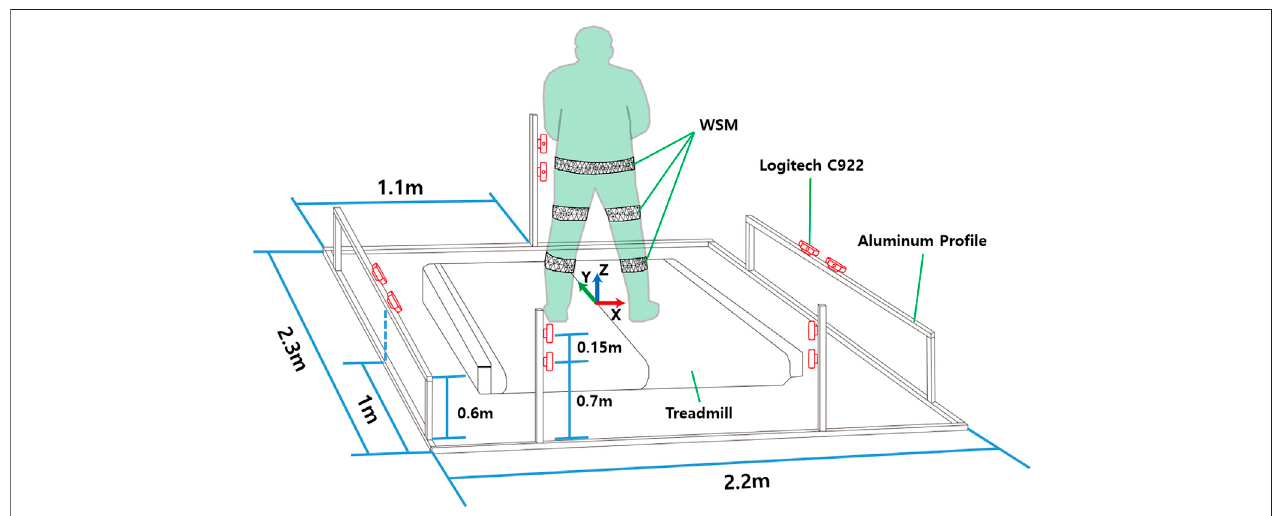
FIGURE 7 | Camera locations for 3-DOF gimbal and human subject experiments. The world coordinates were de fi ned on the center of the